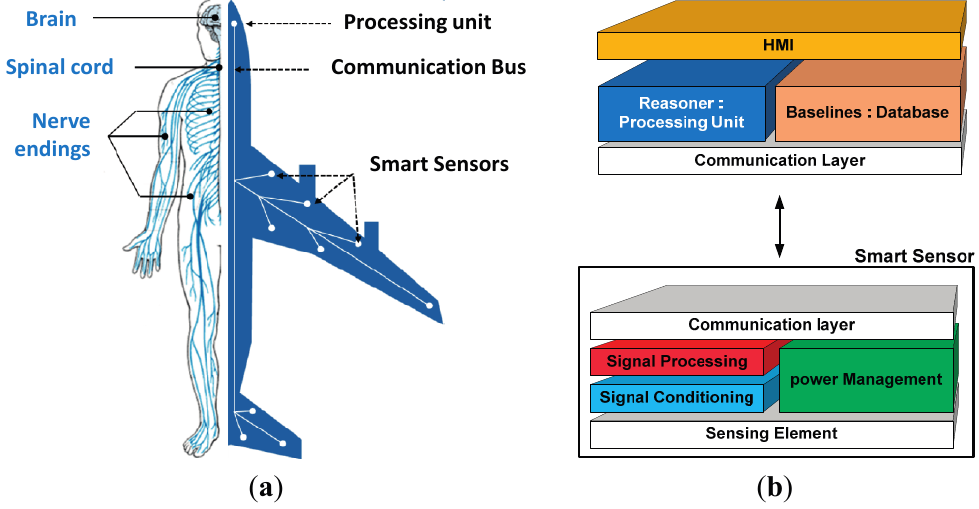
Figure 1. ( a ) Diagnostic system: Analogy with the human body ( b ) Layer model of the proposed smart